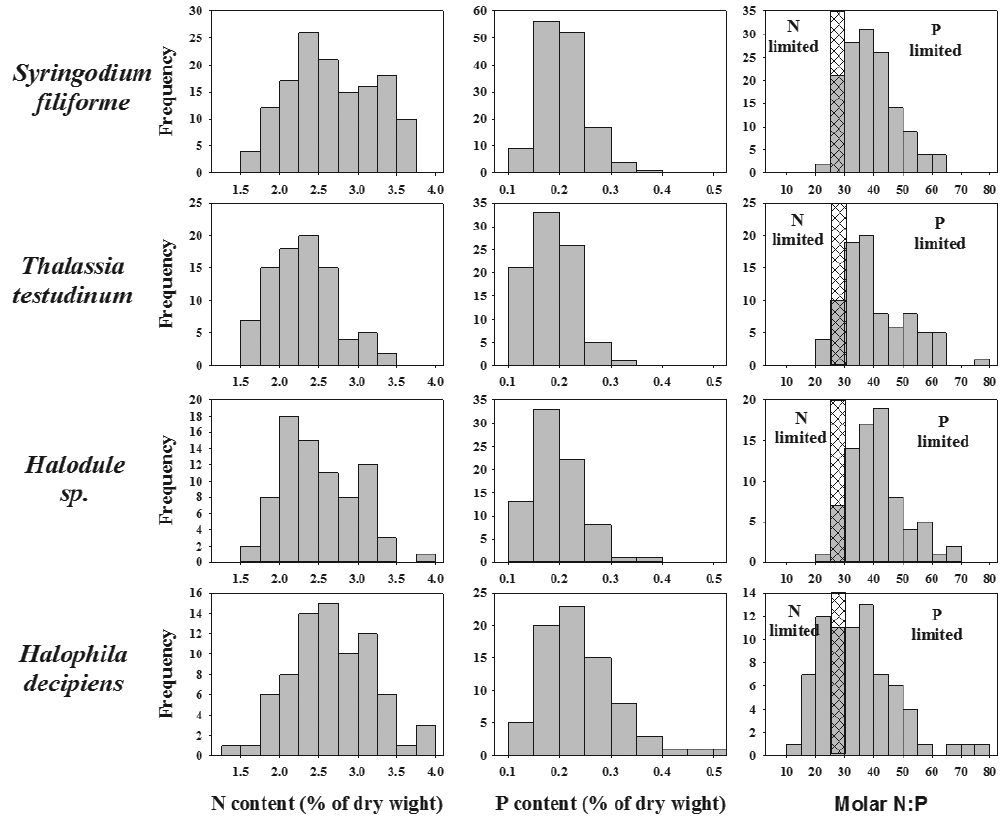
Figure 3. Frequency distribution of the measured carbon, nitrogen and phosphorus content of seagrasses collected on the Bermuda Platform, by species. The cross-hatched region on the molar N:P plots indicates the seagrass Redfield ratio of 25–30; N:P less than this indicates N limitation, while N:P greater than this indicates P